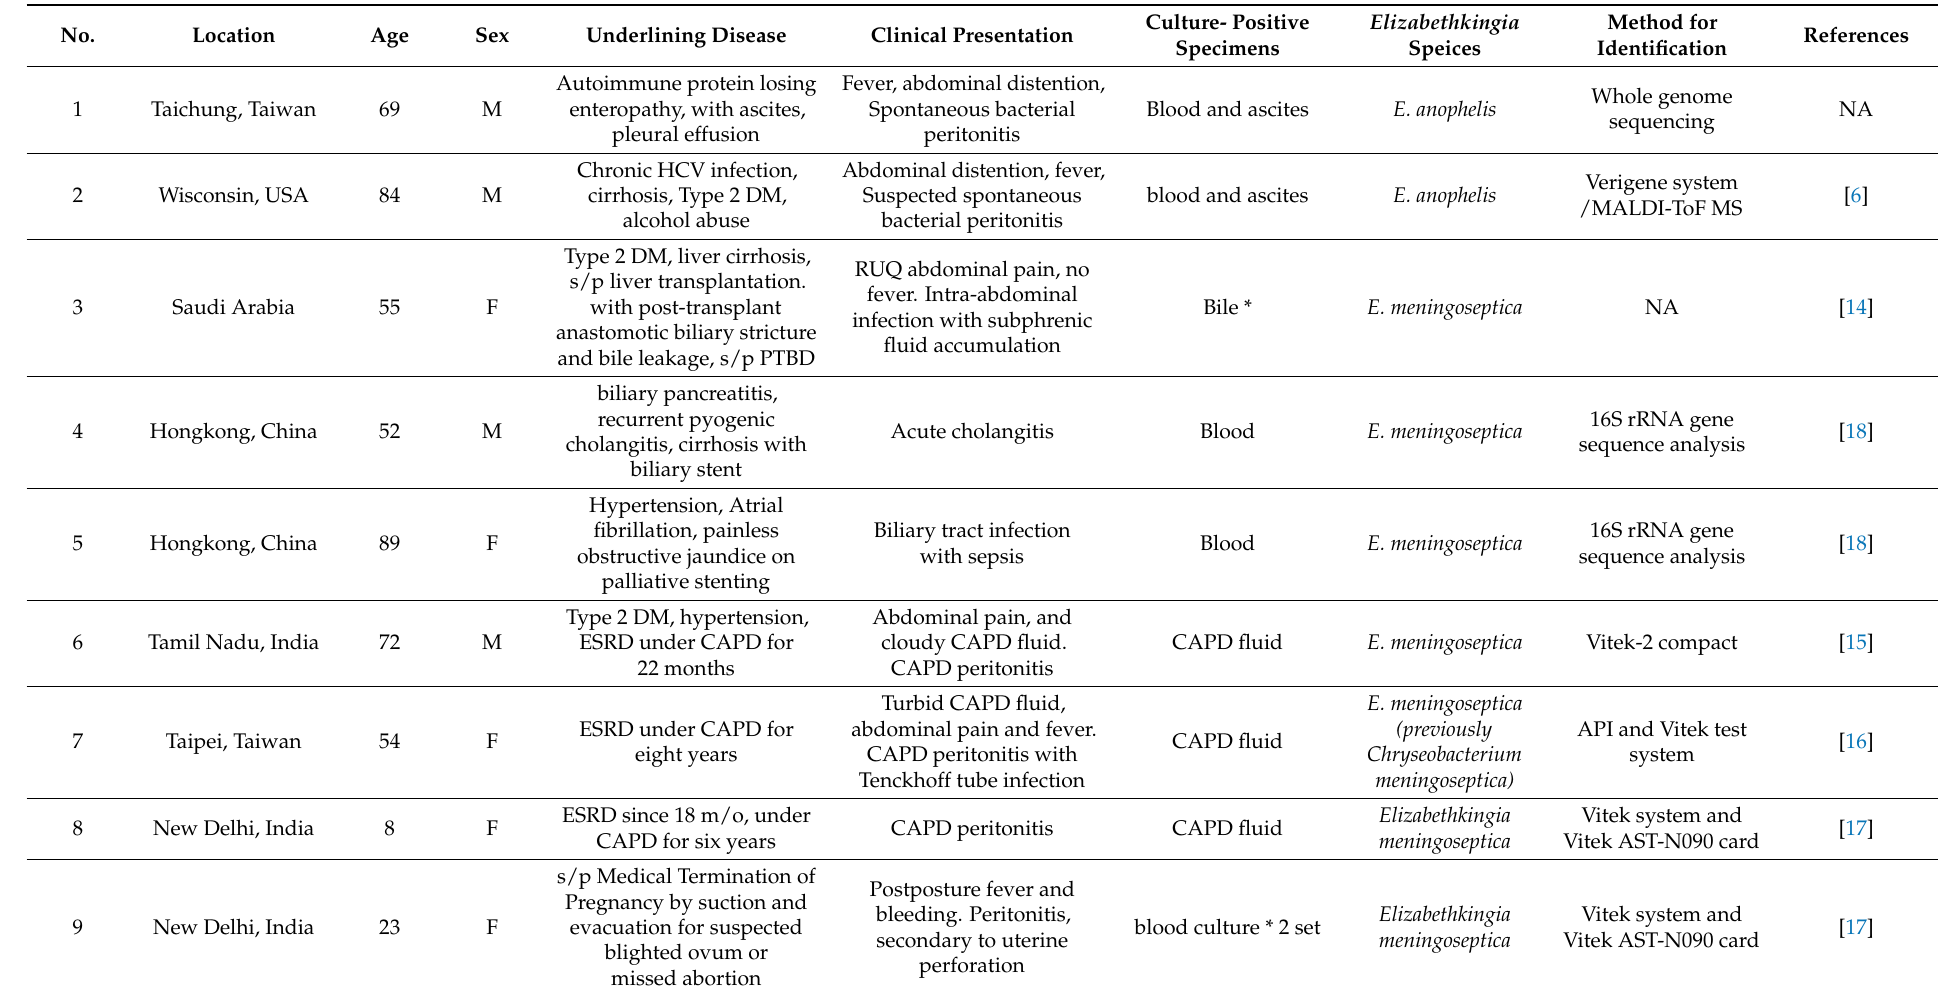
Table 1. Clinical features of intra-abdominal infection with Elizabethkingia